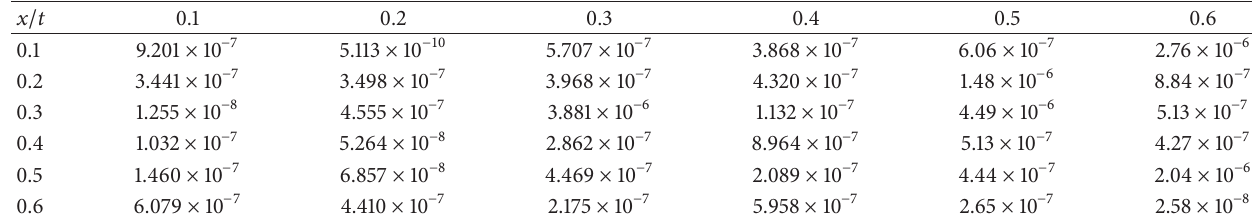
Table 4: The relative error of Example 11 for initial condition at 0.1 ≤ 𝑥 , 𝑡 ≤ 0.6